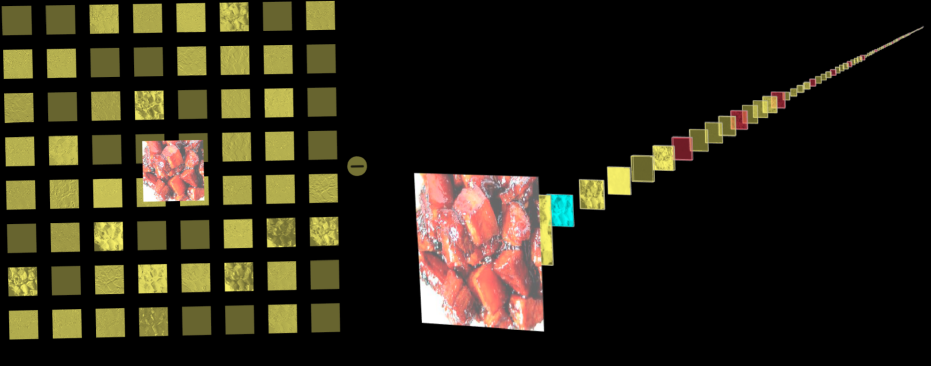
Figure 8. 3D visualization of category CNN by